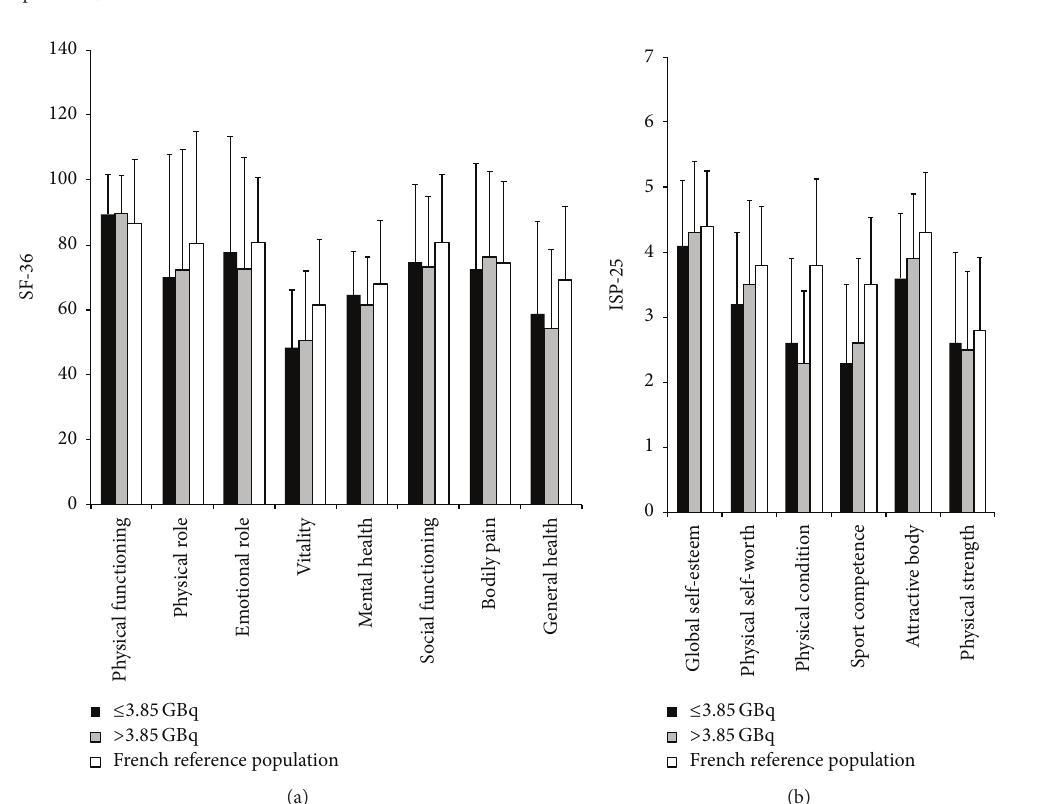
Figure 2: Results of SF-36 (a) and ISP-25 (b) for the two groups of patients (cumulative I 131 activity ≤ 3.85 GBq versus cumulative I 131 activity > 3.85 GBq) and the French reference population [18, 19]. Scores for each questionnaire component are represented as means ( ± SD). pregnancy was comparable for both study groups and was dose of I 131 > 3.85 GBq and 10 in patients who received a dose of ≤ 3.85 GBq. Frequency of miscarriages was of 17% in 69.7 months for the patients who received cumulative I 131 females from the group > 3.85 GBq and 10% in patients with dose ≤ 3.85 GBq and 75.3 for the patients with cumulative I 131 dose > 3.85 GBq. Forty pregnancies after administration of cumulative I 131 dose ≤ 3.85 GBq. In total, 9 and 24 live births were noted for the first and the second groups, I 131 were observed: 30 in patients who received cumulative